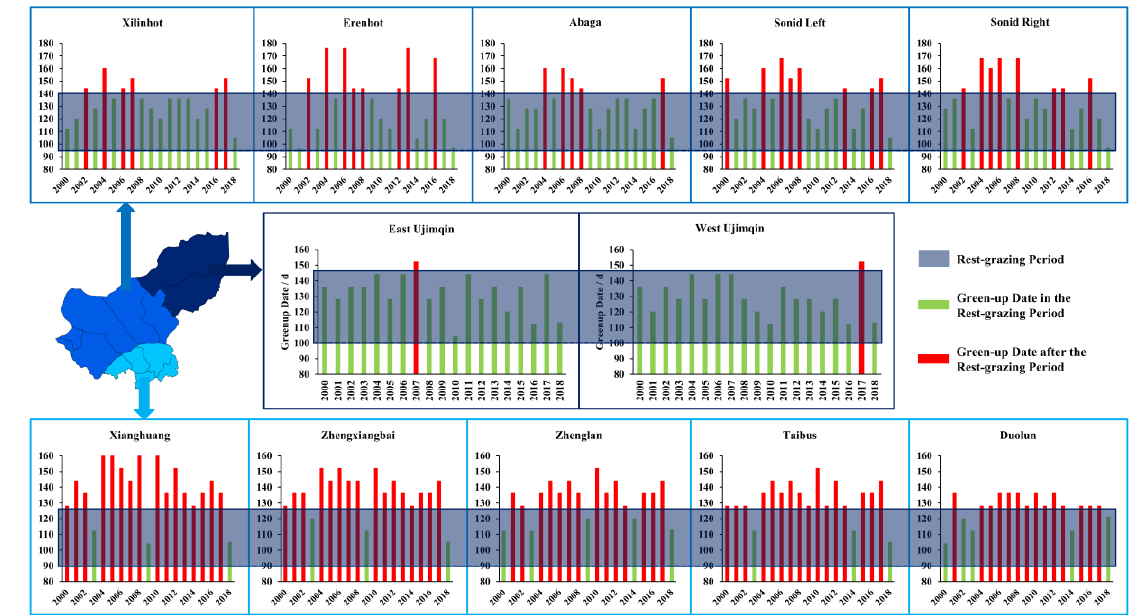
17 in such areas where rest-grazing started later than the green-up date (Figure 6c). In the other areas where rest-grazing started before the green-up date, the grazing days were 10, 23, 36 and 45 in such areas where the gaps between the two dates were 0~15, 15~30, 30~45 and >45, respectively (Figure 6c). The grazing days during the green-up process increased gradually with the widening gap between the green-up date and rest-grazing date, which also means the increasing ecological pressure on the grasslands. Figure 5. Comparison between annual green-up date and rest-grazing period in each county.